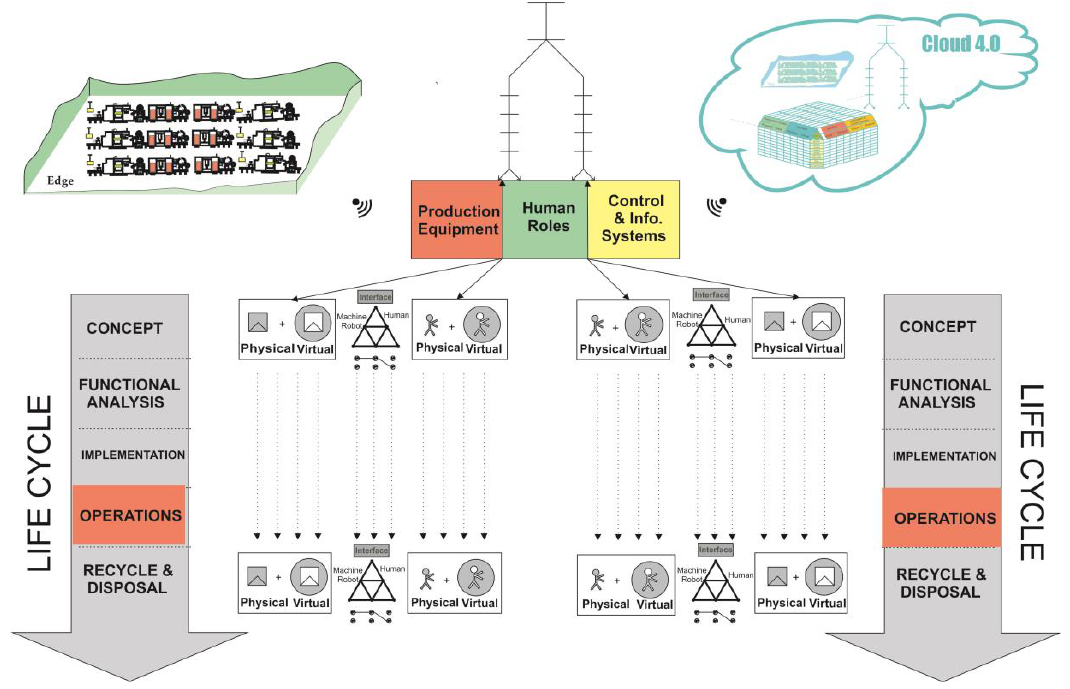
Figure 10. Integrating DfHFinI4.0 in PERA 4.0 operations phase.